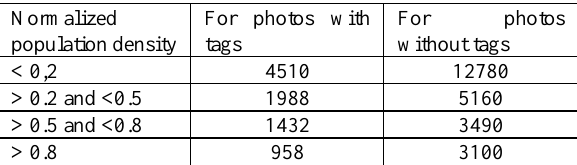
Table 2. Coordinate prediction results for posts containing tags Another group of objects was identified and evaluated according to the quality criterion for automatic tagging using a neural network (table 3).